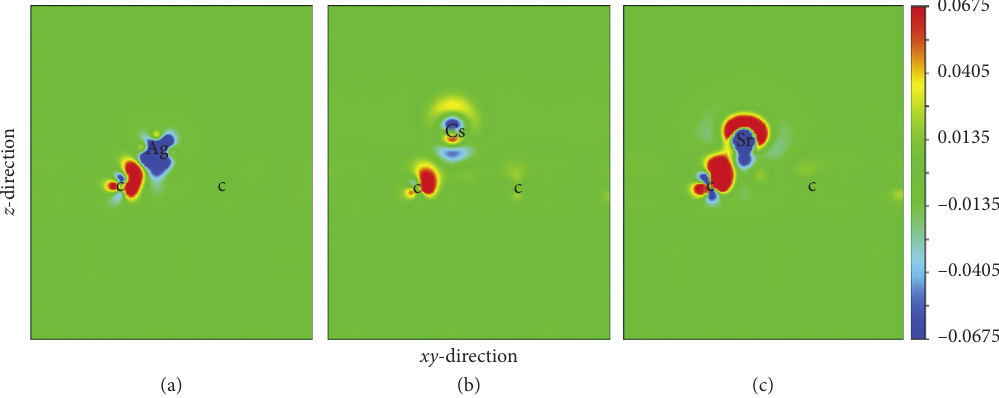
Figure 7: Charge density difference (CDD) based on the green bash lines shown in Figure 4(d) of Ag, Cs, and Sr on matrix graphite surface with single vacancy defect. (a) Ag; (b) Cs; and (c) Sr. Red and blue areas represent positive and negative charge differences. Isosurface level was set at 0 . 0069e/˚A 3